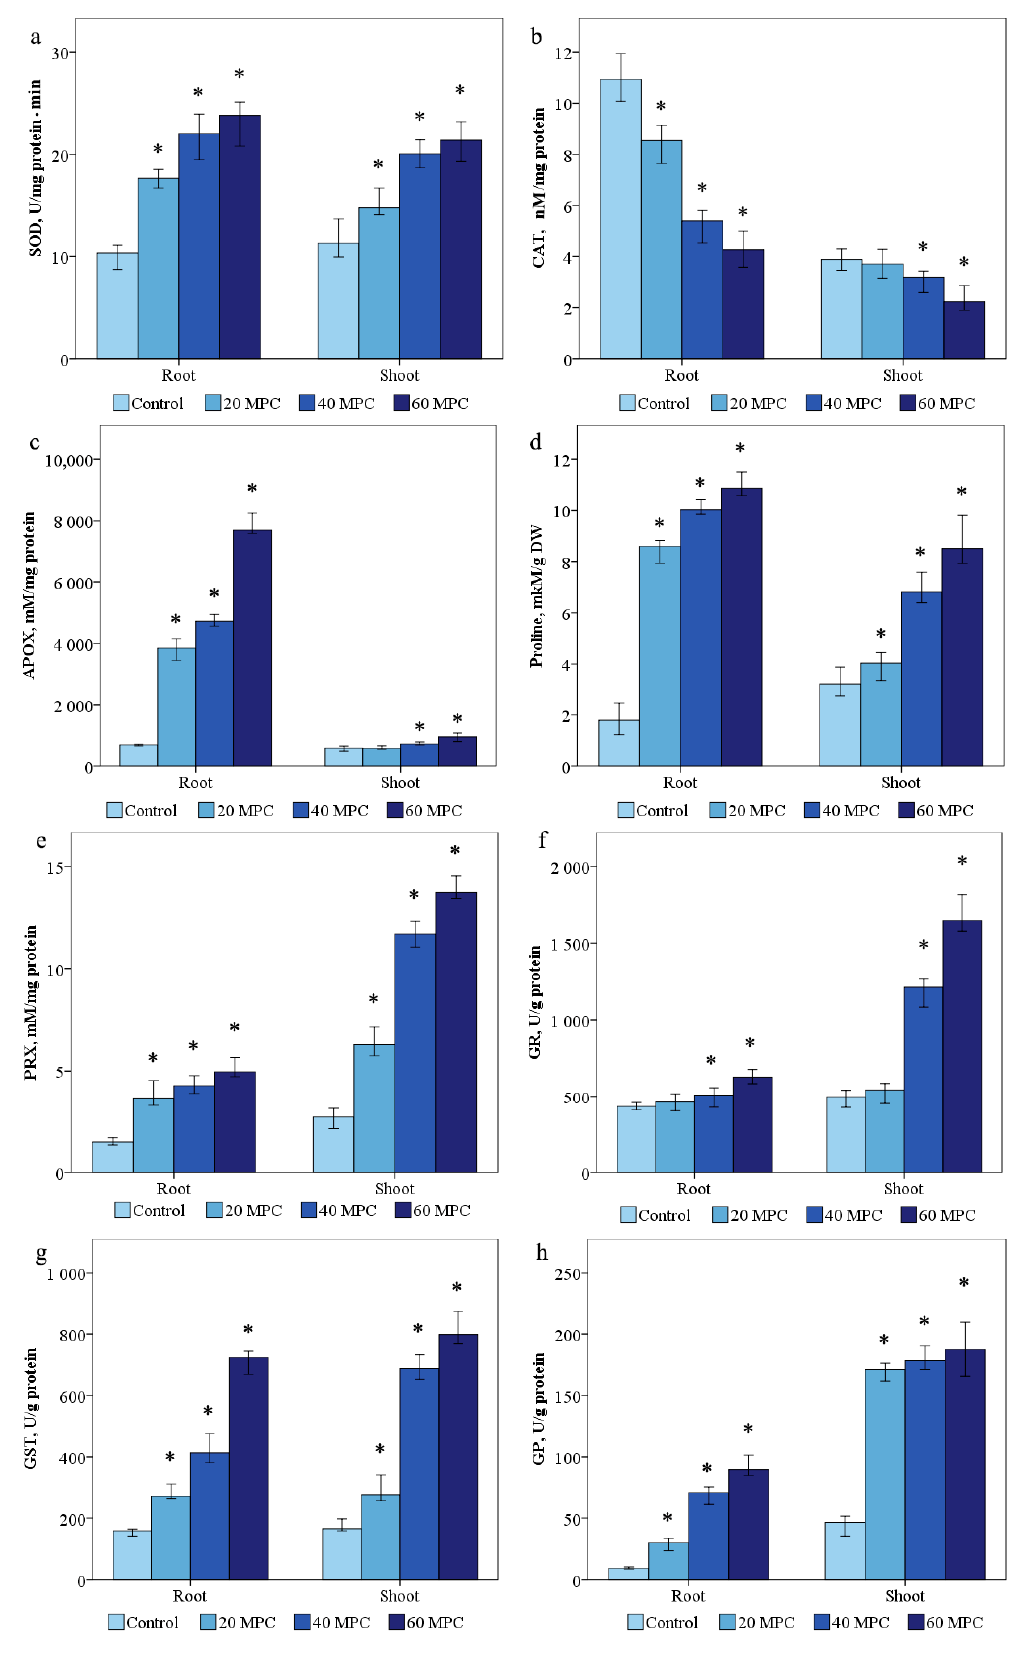
Figure 4. Effect of BaP on ( a ) SOD, ( b ) catalase, ( c ) proline, ( d ) PRX; ( e ) APOX, ( f ) GR, ( g ) GST, ( h ) GP in Solanum lycopersicum plants. Statistically significant differences ( p ≤ 0.05) comparing the treated plants to the control plants are marked with an asterix (*).